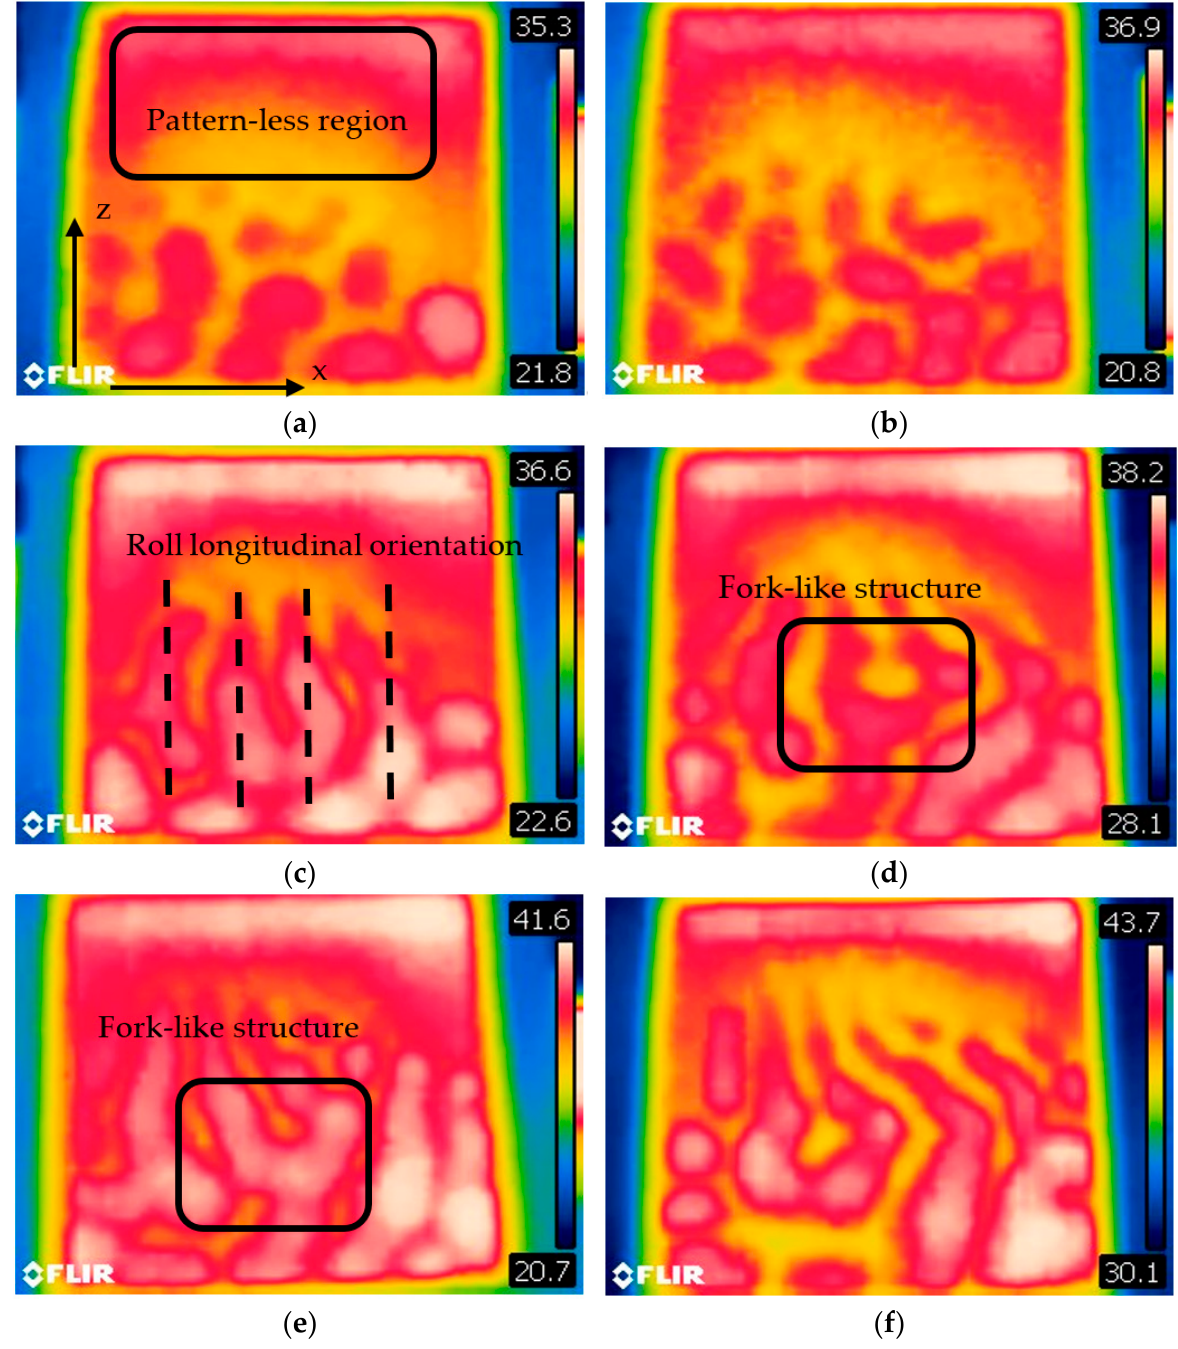
Figure 6. Surface temperature distribution for d = 0.50 cm ( Ω = 32 mL) and ϑ ≅ 3.5° ( A = 16, Bo dyn ≅ 0.86, Ra ≅ 2.5 × 10 2 × ∆ T , Ma ≅ 2.94 × 10 2 × ∆ T ): ( a ) ∆ T = 15 °C, ( b ) ∆ T = 18 °C, ( c ) ∆ T = 21 °C, ( d ) ∆ T = 24 °C, ( e ) ∆ T = 27 °C, ( f ) ∆ T = 30 °C (the x and z axes correspond to the horizontal and vertical directions in all the panels).